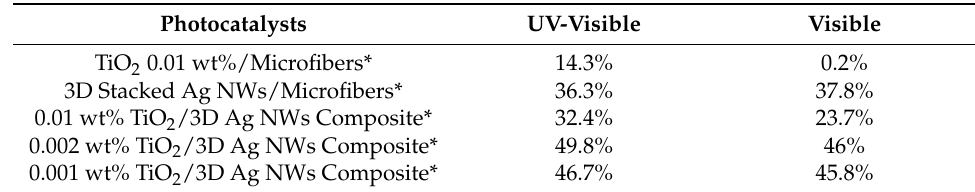
Figure 5. Time-dependent UV-vis spectra of an MB aqueous solution after illumination in the presence of 0.002 wt% TiO 2 /Ag NW composites under ( a ) UV-visible light and ( b ) visible light. Table 2. The photocatalytic efficiencies of different photocatalysts under AM 1.5G and visible and NIR (the UV was cut off by a filter) light after 10 min